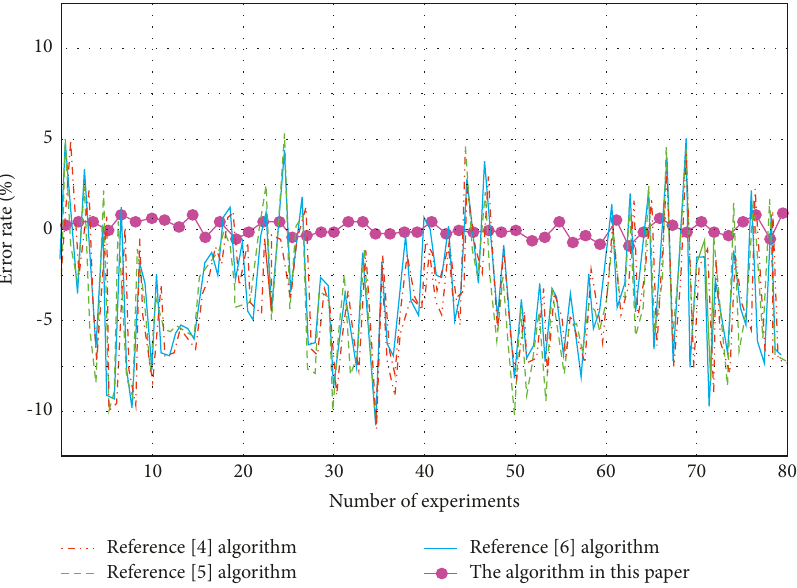
Figure 3: Calculation error